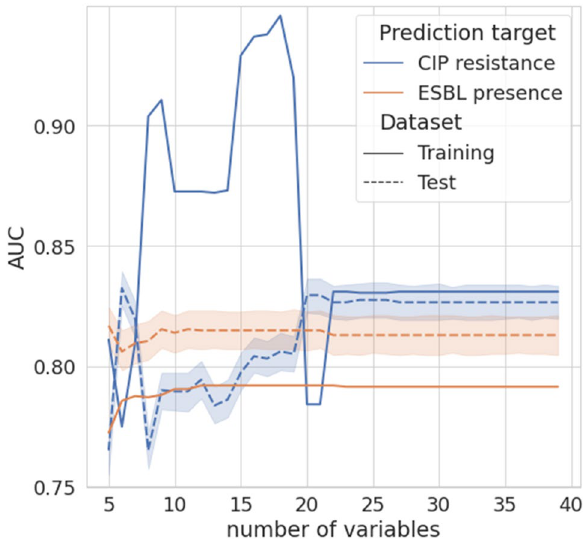
Figure 6. Performance according to the number of predictors. Average AUCs with 95% confidence intervals (colored region) for predicting CIP resistance (blue) and ESBL positivity (orange) each for training (solid lines) and testing (dotted lines) sets were shown.